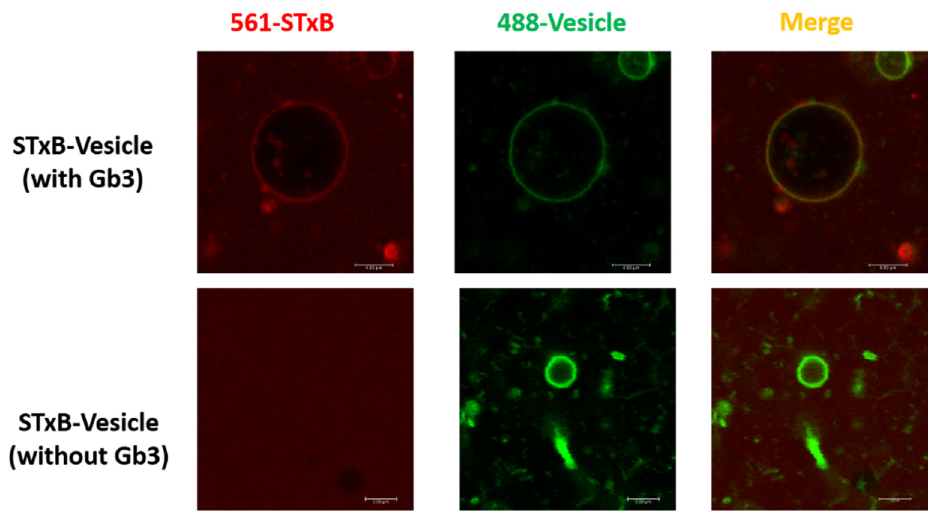
Figure 1. Novel pentamer Shiga toxin B subunit reconstitution method. The Shiga toxin B subunit purified with novel strategy can bind with Gb3 glycosphingolipids in GUVs. GUVs were composed of DPPC (spiked with 1 mol% BodipyFL-C5-HPC, Green), containing Gb3 ganglioside. [Gb3]/[DPPC] = 0.1/1; STxB (Cy3, Red) was incubated with GUVs at 37°C.